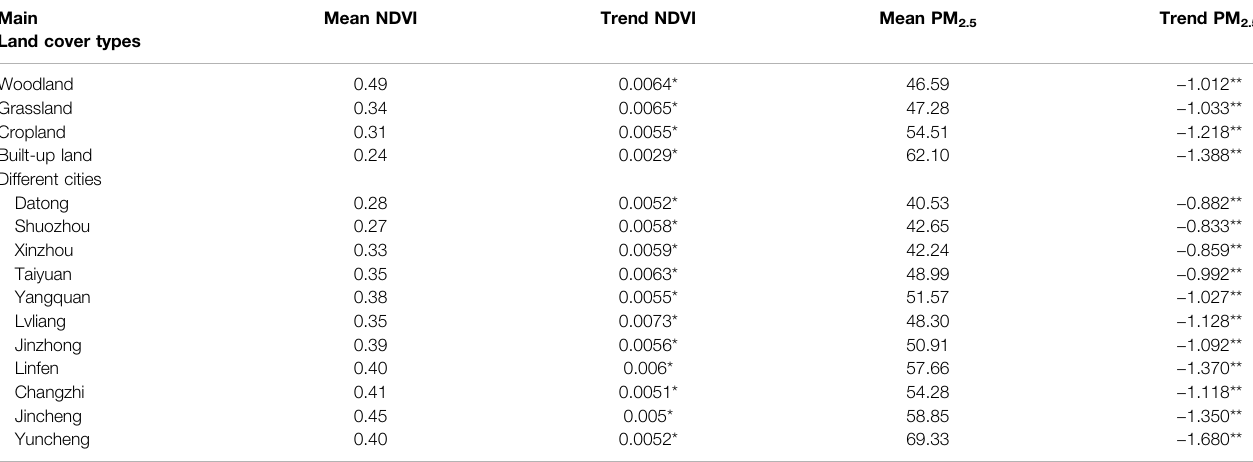
TABLE 2 | The changes of mean annual NDVI and PM 2.5 in main land cover types and different cities.